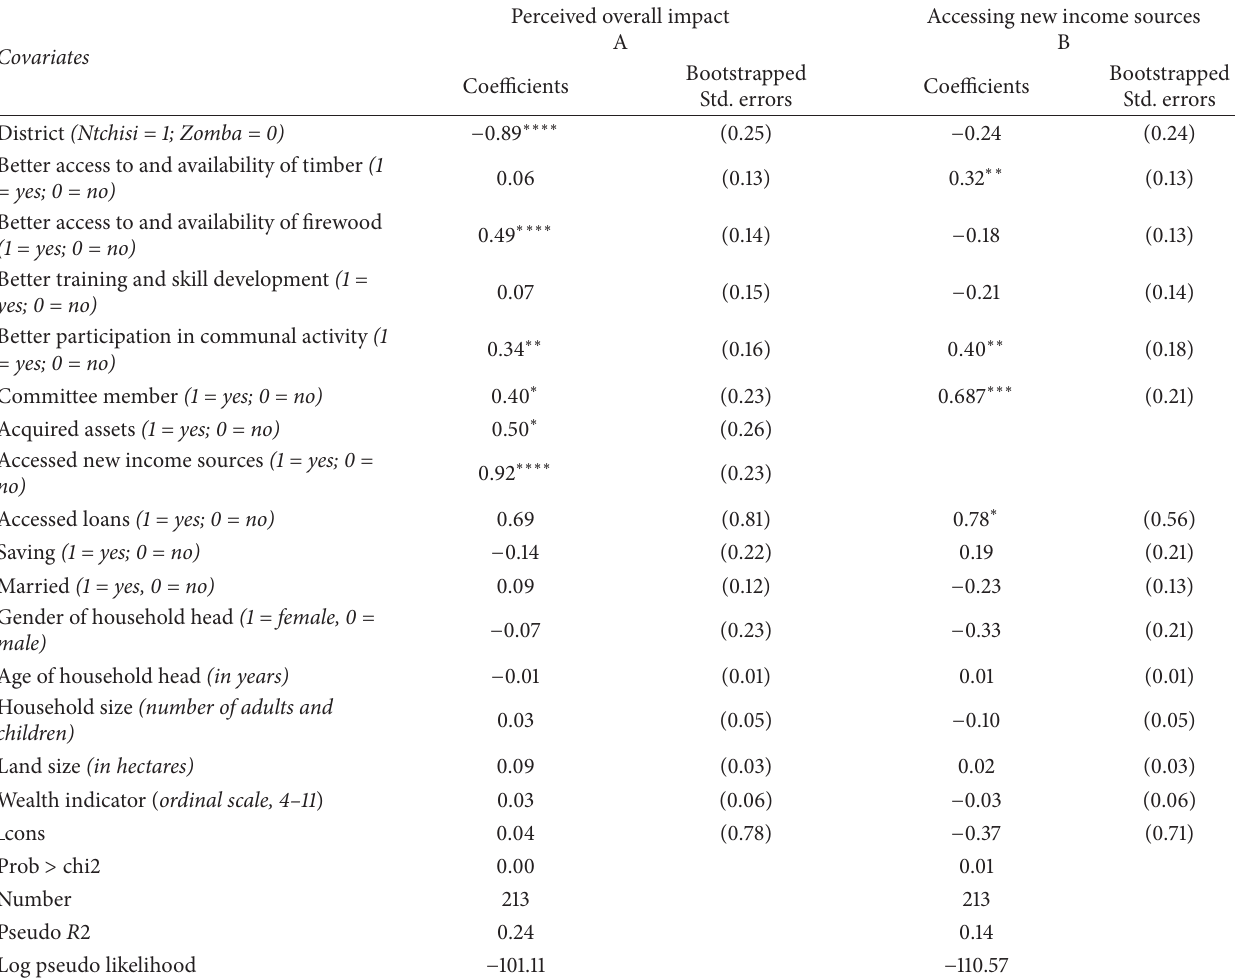
Table 4: Probit regression result on factors affecting perception of programmes overall impact and accessing new income sources.